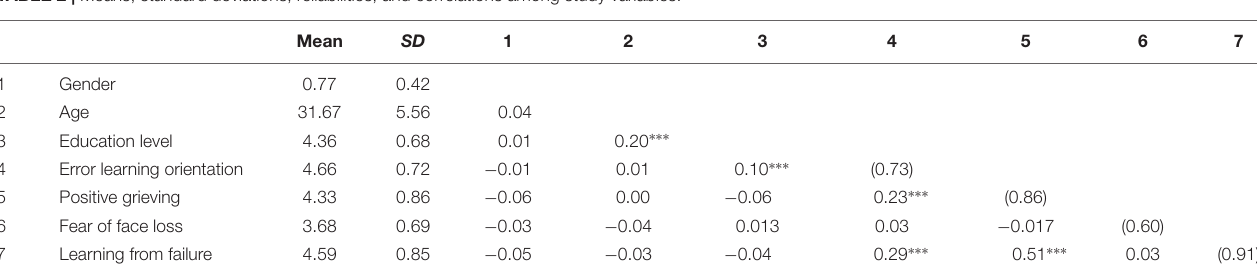
TABLE 2 | Means, standard deviations, reliabilities, and correlations among study variables.